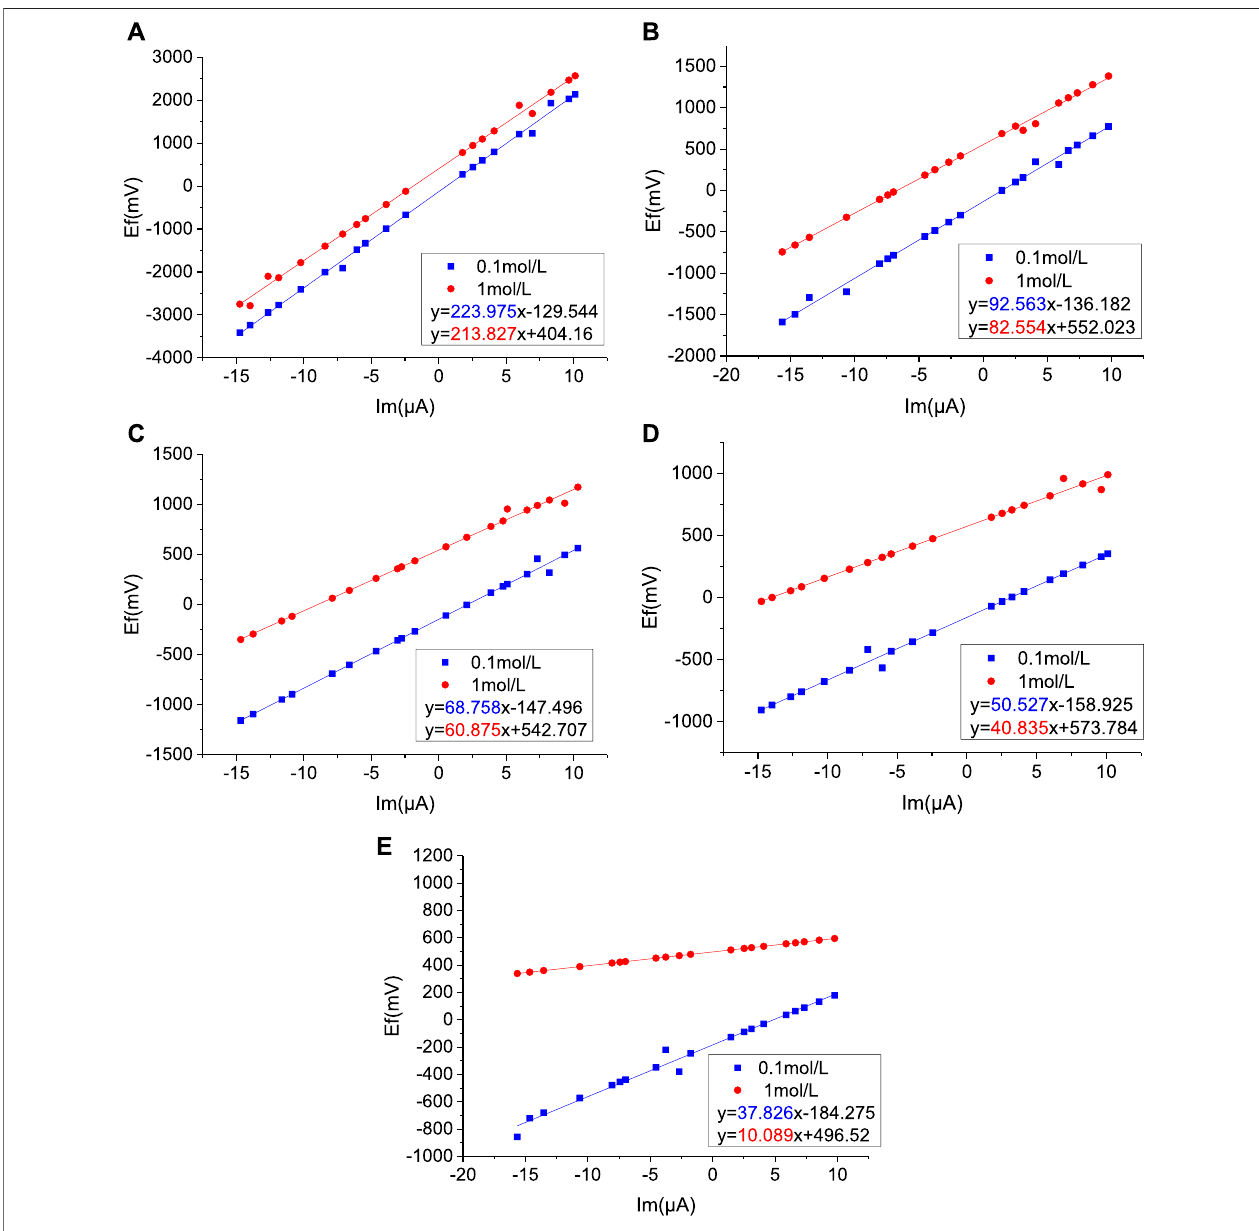
FIGURE 8 | Fitted polarization resistance of S3 and S6 at different times (A) 1d, (B) 3d, (C) 7d, (D) 15d, and (E) 30d.